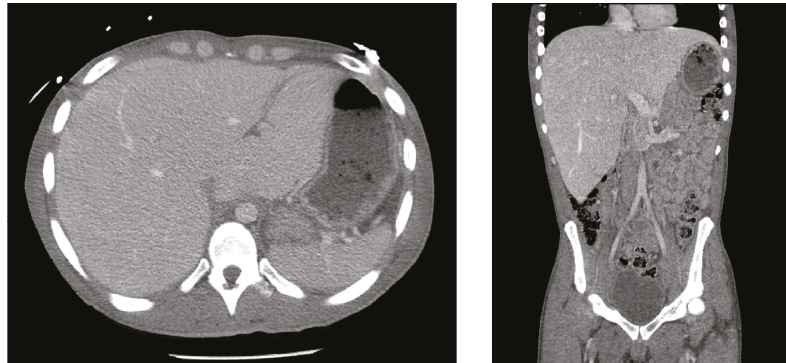
Figure 1: Axial and coronal sections of the abdominal CT scan showing hepatomegaly with a hyperdense liver.